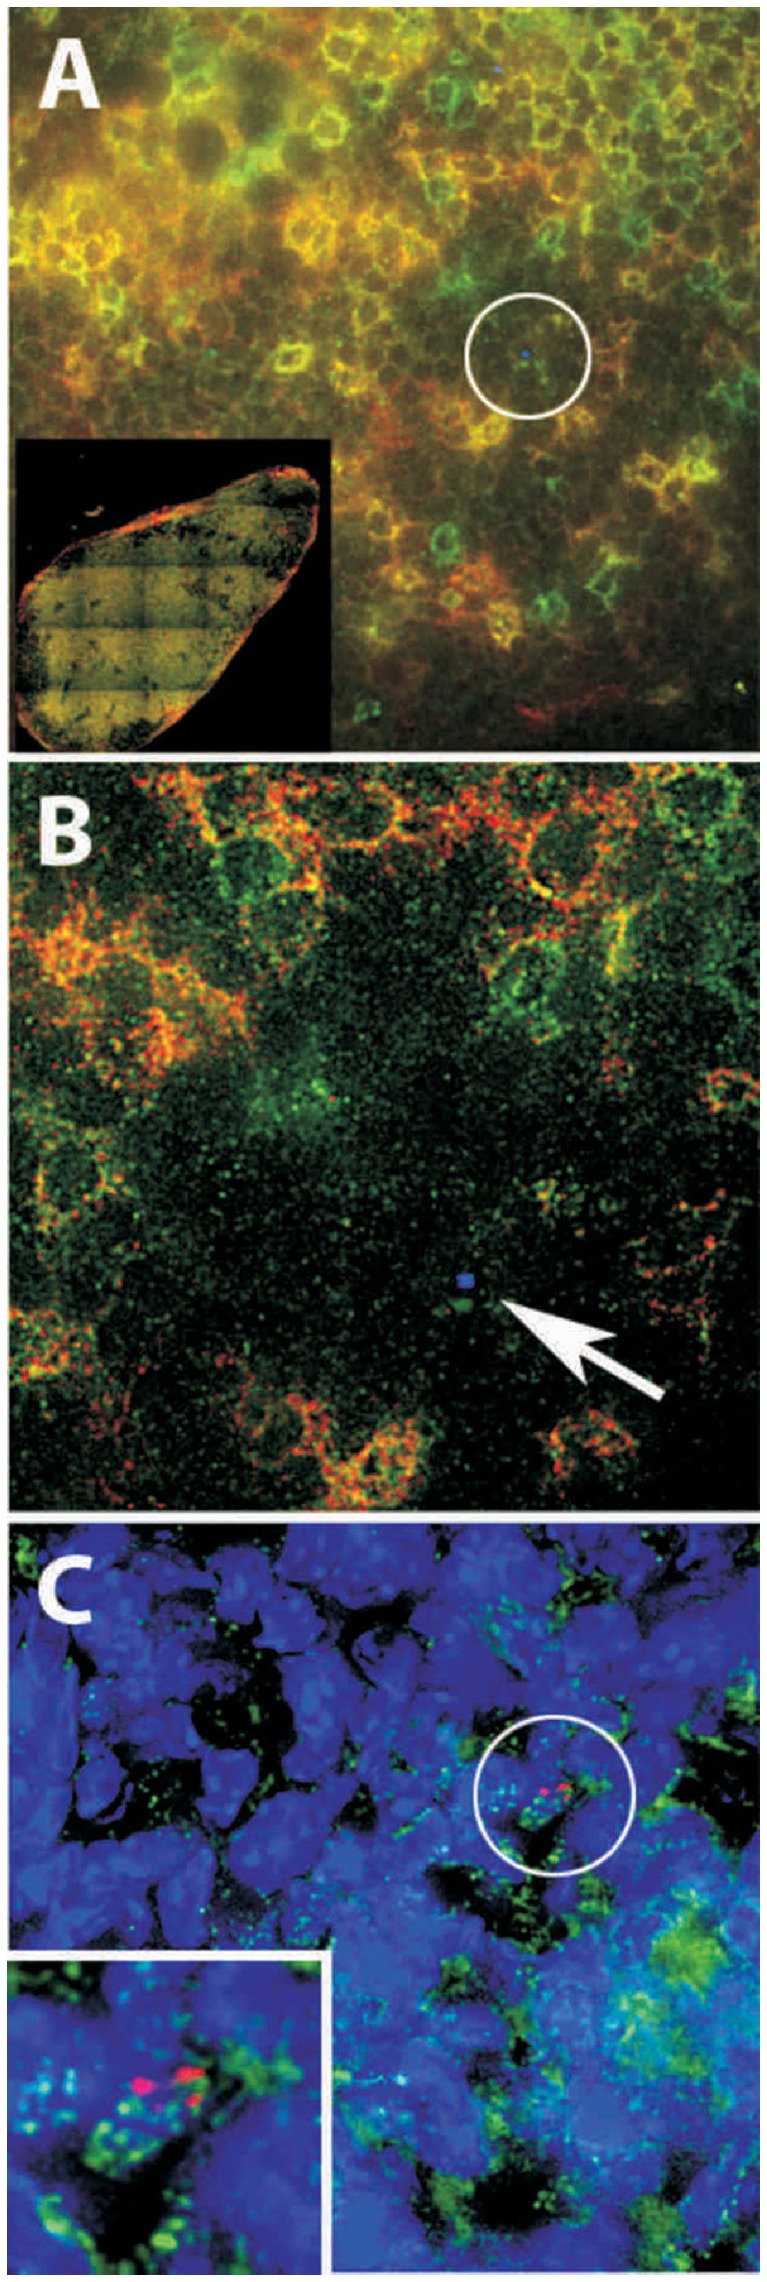
Identification of Qdots in draining lymph nodes.A. CD3 staining (green) and CD4 staining (red) in mouse lymph node. N-9 pretreatment and instillation were as described in Figure 1. Inset shows tiled panel of entire lymph node. B. Region in white circle from A, which contains a Qdot aggregate, false-colored blue, which is not associated with CD4 or CD8 cells (arrow). C. Qdots (red) associated with macrophage (CD11b, green). Blue, DAPI.